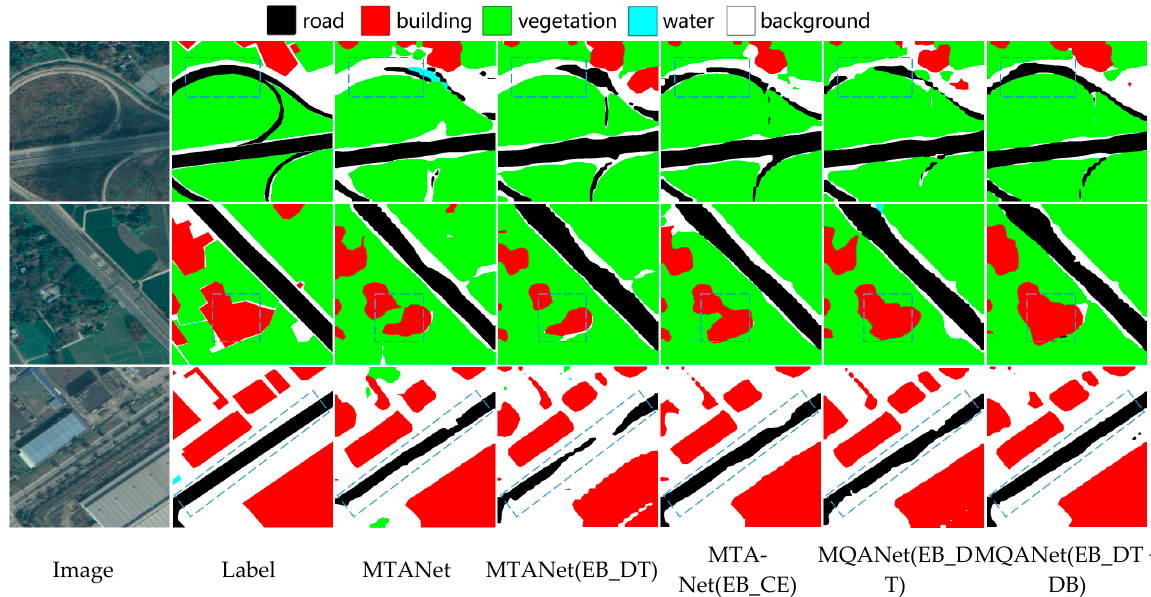
Figure 14. Examples of semantic segmentation results on ablation study of edge optimization (CZ-WZ dataset).